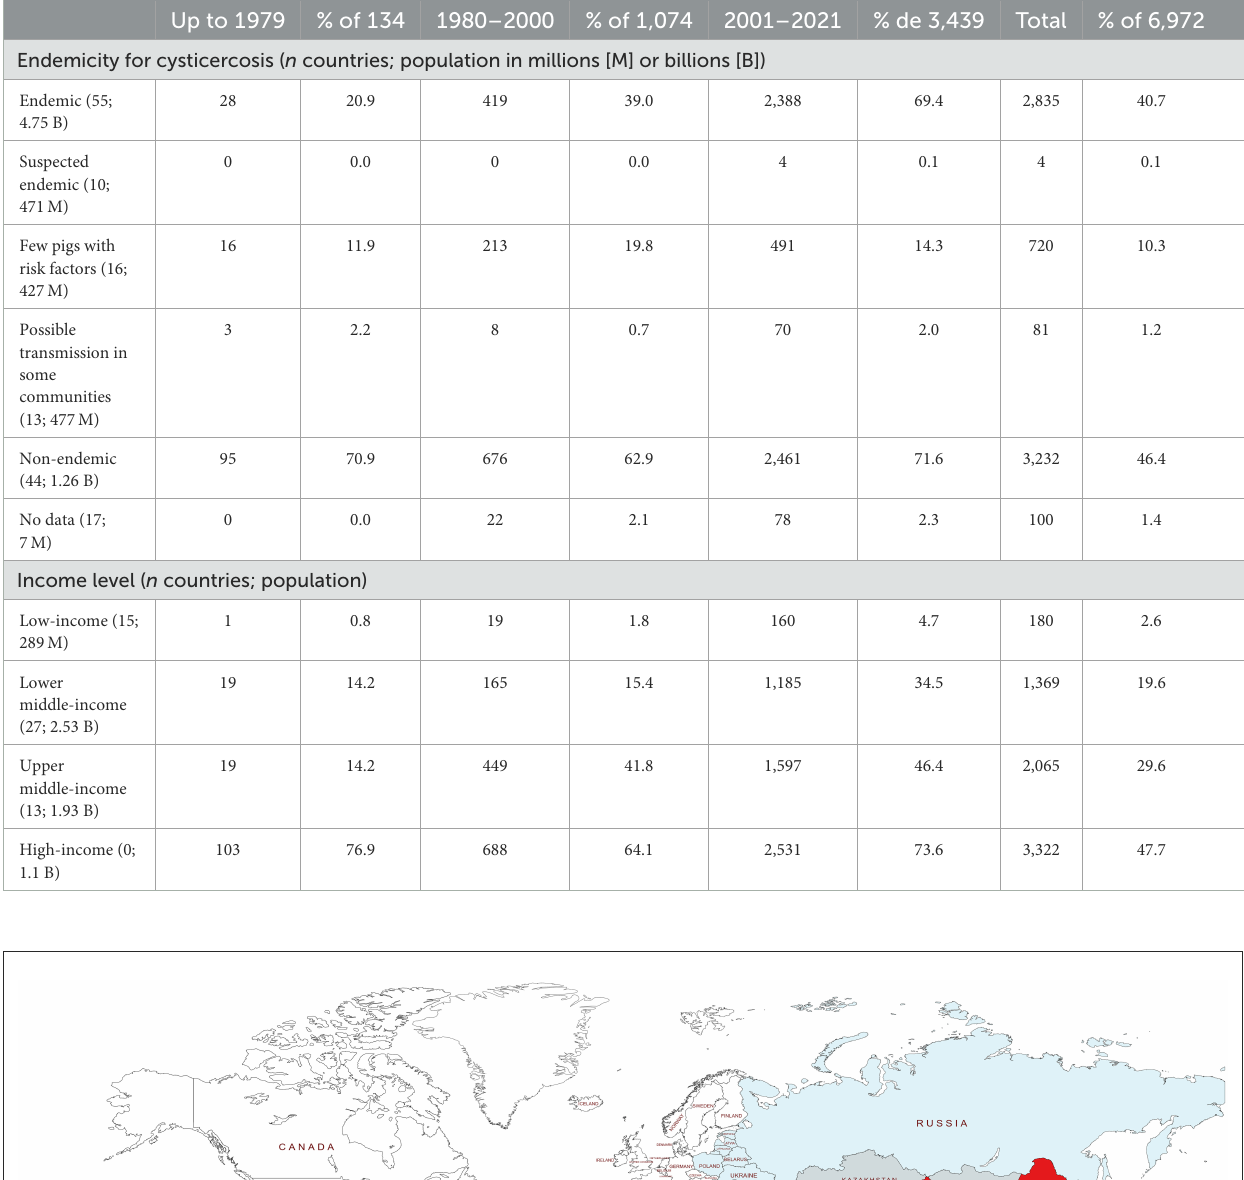
TABLE 3 Participation in research on cysticercosis and neurocysticercosis by country, according to endemicity and income level ( N = 6,972 publications included in the Web of Science Core Collection). Up to 1979 % of 134 1980–2000 % of 1,074 2001–2021 % de 3,439 Total